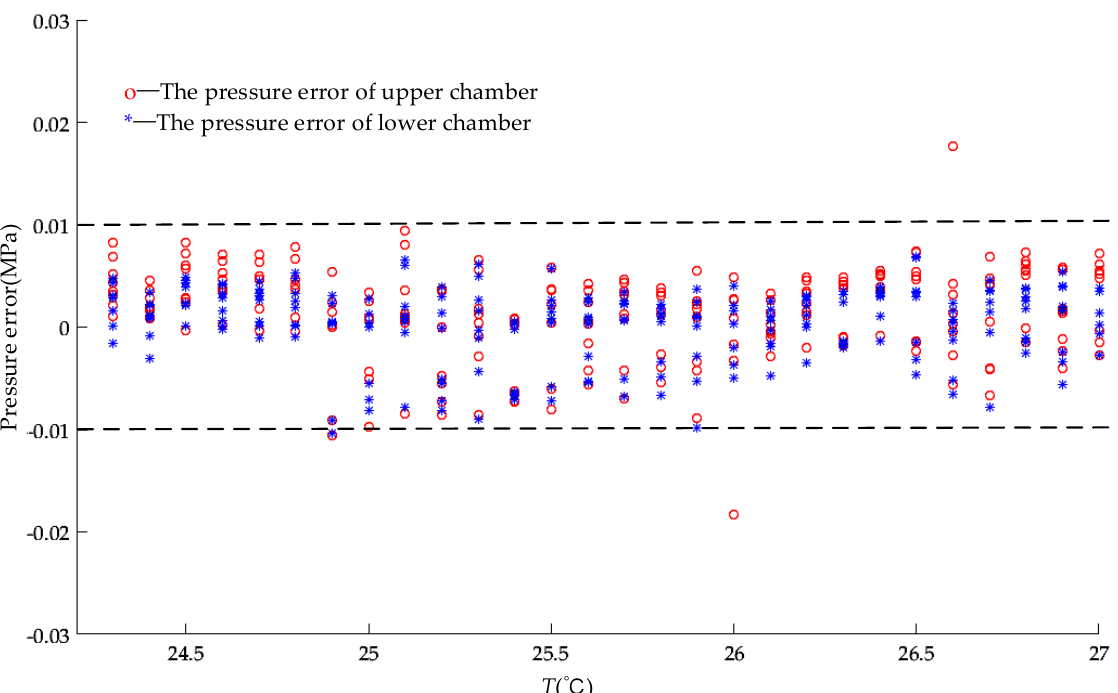
Figure 11. Pressure error of the upper and lower chambers when injecting unfiltered air.